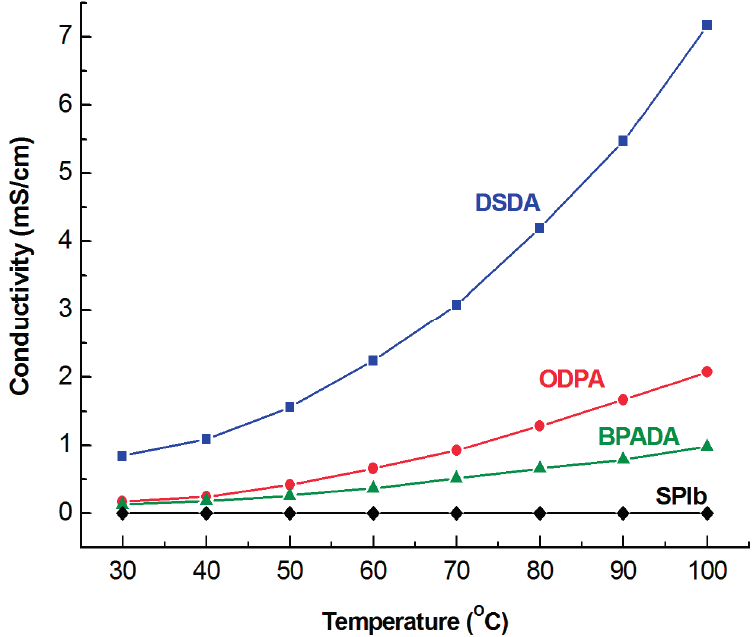
Figure 8. Temperature dependence of the conductivity of SPIb/V5 composite membranes and pristine SPIb membranes made by various dianhydrides. The conductivity data of composite membranes made from dianhydride ODPA (curve “ODPA”) were from